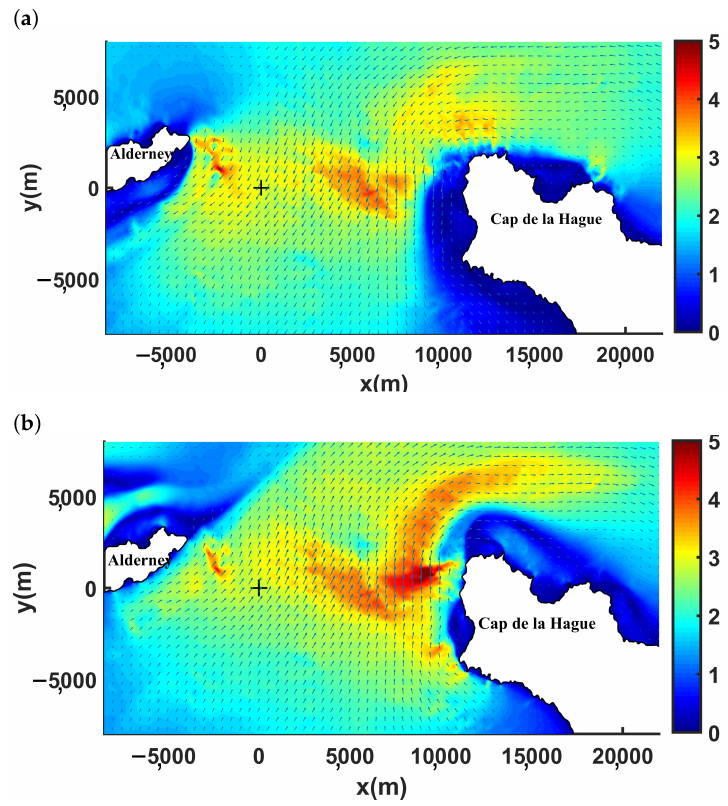
Figure 9. Spatial distribution of depth-averaged velocities (m/s) at ( a ) peak ebb and ( b ) flood during a mean spring tide in the Alderney Race (simulation without turbines). The cross represents the centre of the tidal farm. The origin of the reference frame (coordinates in m) corresponds to the centre of the